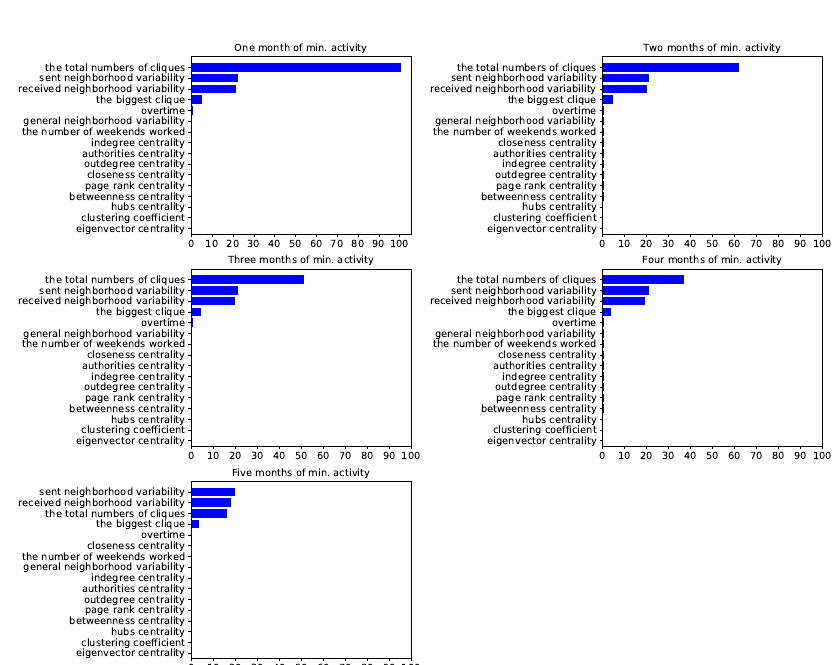
Figure A6. Features importance (based on univariate feature selection method which uses chi-squared test) for the Neural Network and SVM which use the full set of features for the manufacturing company dataset with three levels of the